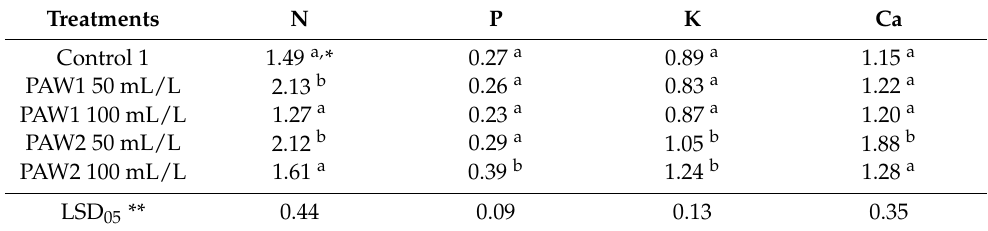
Table 2. The effect of PAW on the primary nutrient contents in apple leaves, % d.m. Treatments N P K Ca Control 1